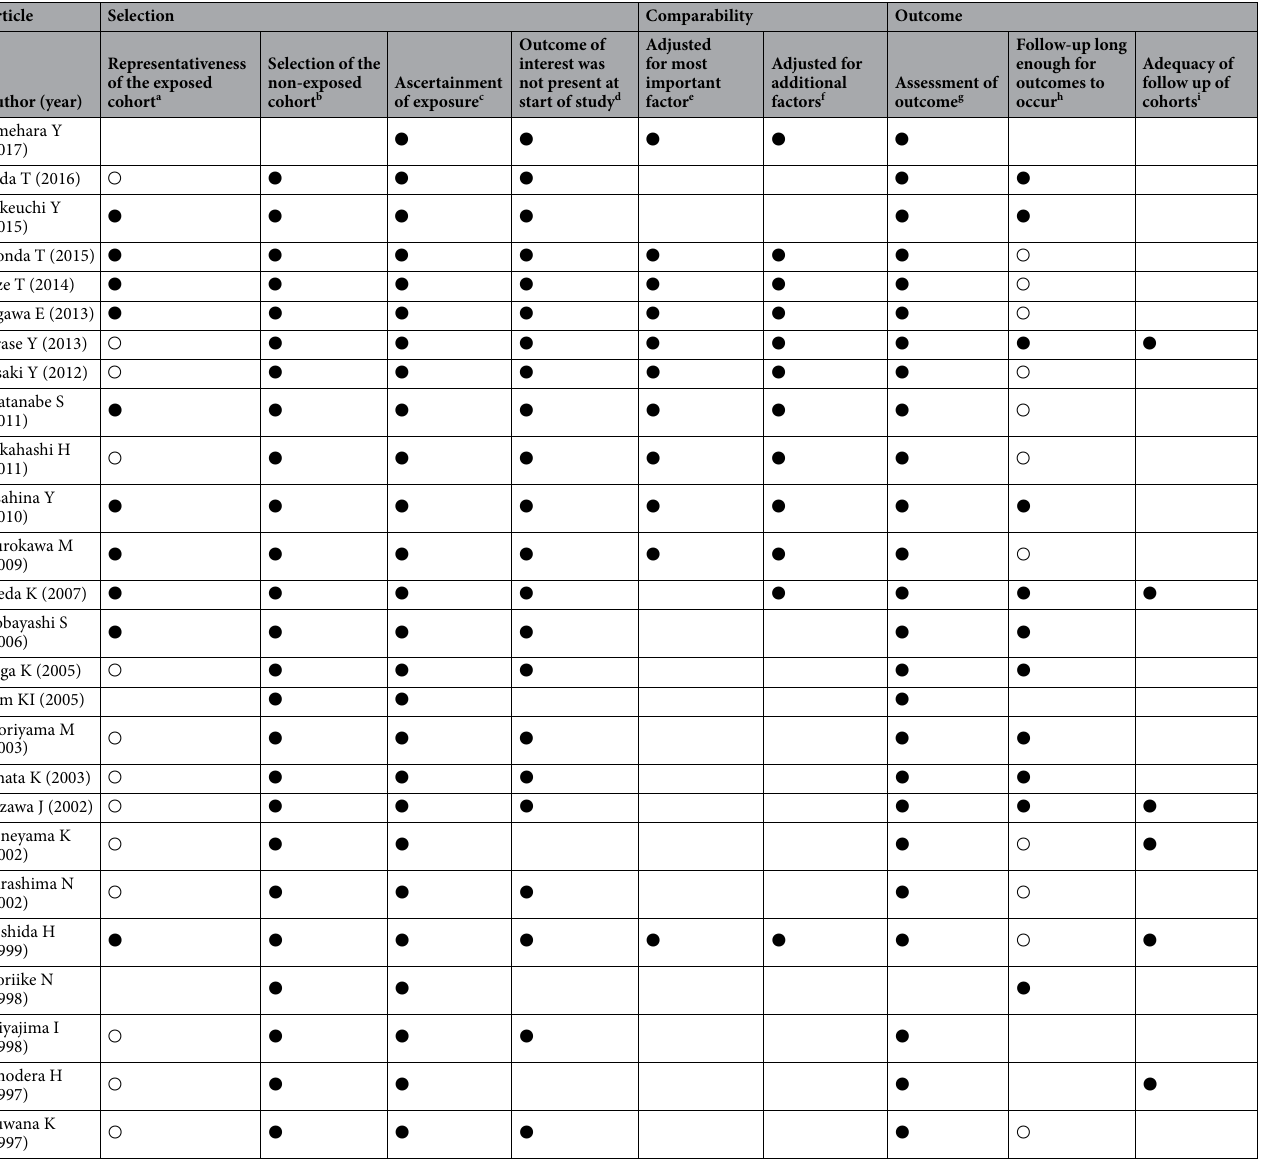
Table 2. Risk of bias assessment using the Newcastle–Ottawa Scale for 26 studies. a Single ( ○ ) or multi- center ( ● ) hospital-based study. b Drawn from the same community as the exposed cohort. c Based on medical records. d Demonstrated. e Adjusted for fibrosis. f Adjusted for age and other factors. g Based on medical records. h Mean follow-up duration > 3 years ( ○ ) and > 5 years ( ● ). i Reported number lost to